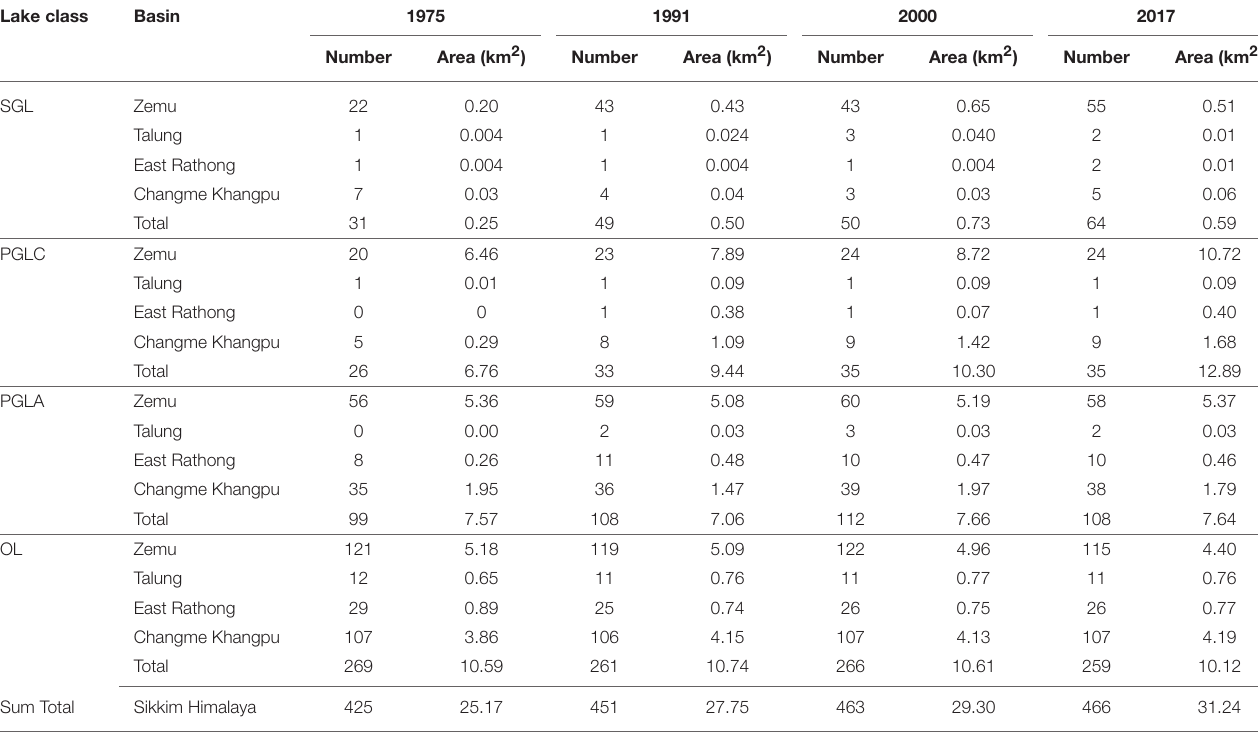
TABLE 3 | Temporal change in various lake types from 1975 to 2017 in the Sikkim Himalaya. Lake